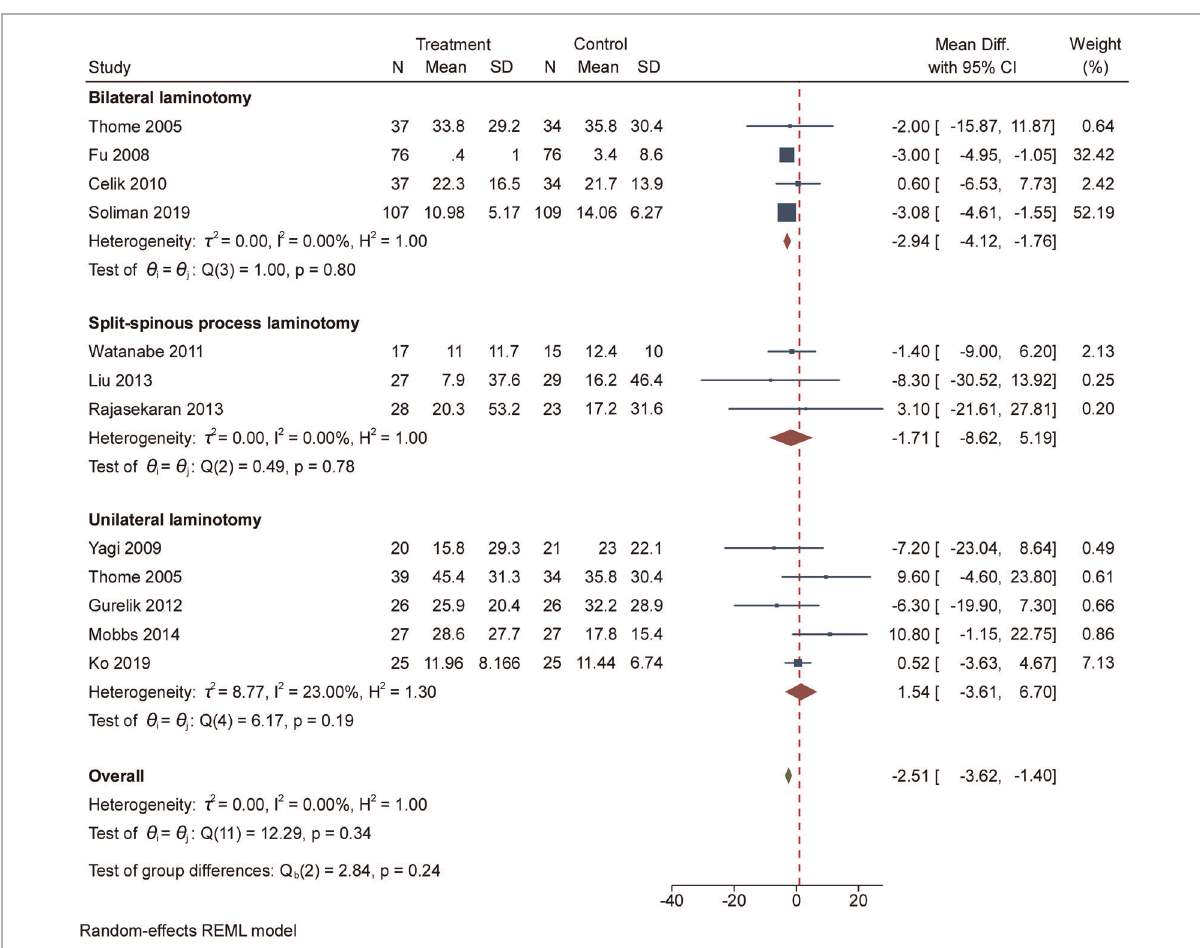
FIGURE 2 The forest plot regarding standardized disability index compared posterior techniques with tourniquet